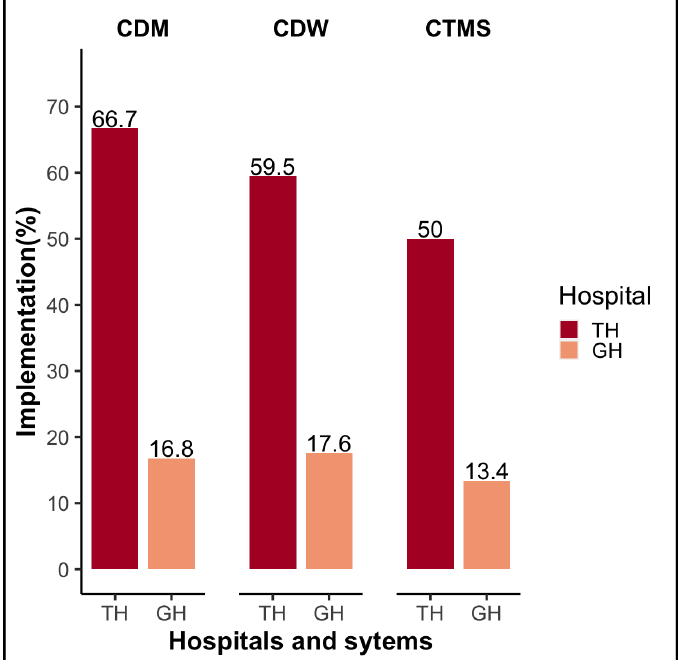
Figure 4. Status of CDM, CDW, and CTMS for secondary use of clinical data Abbreviations: CDM, common data model; CDW, clinical data warehouse; CTMS, clinical trial management system; TH, tertiary hospital; GH, general